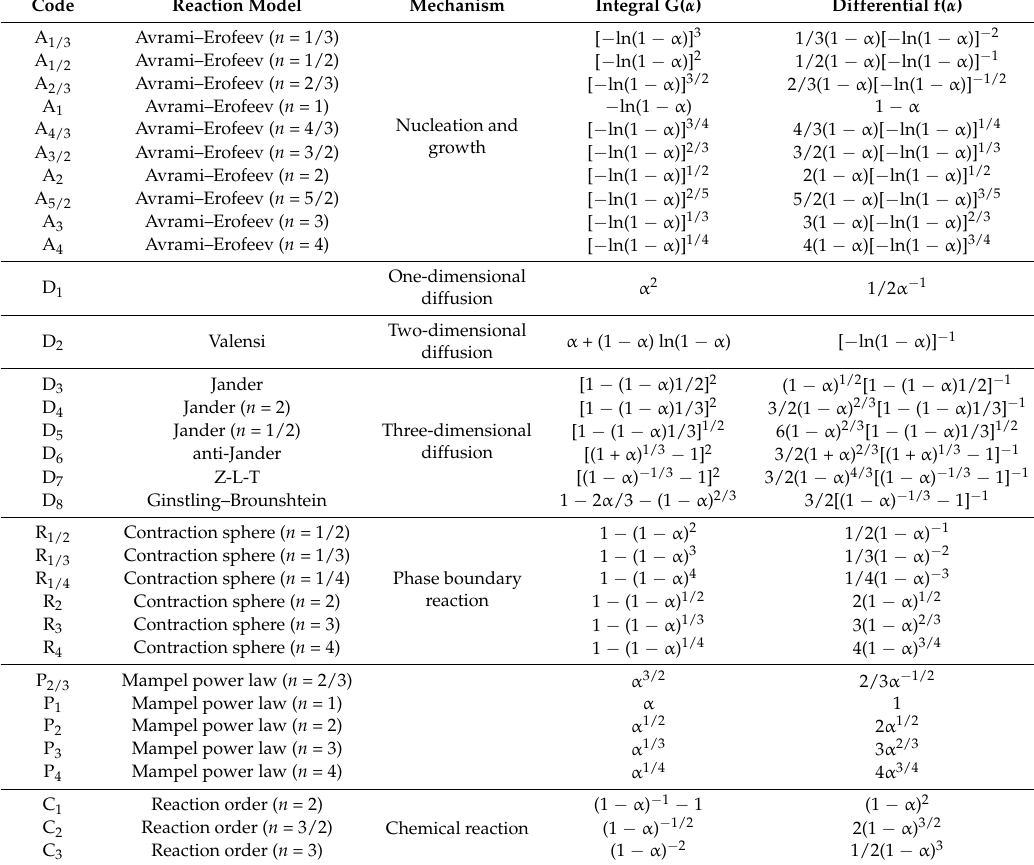
Table 3. Gas–solid reaction models with corresponding mechanism and function